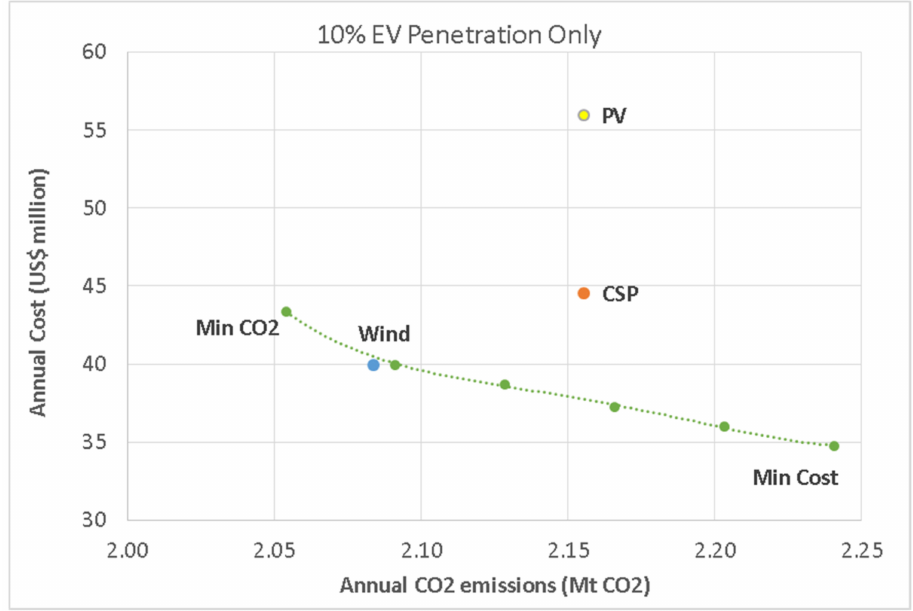
Figure 6. Tradeoff between annual cost and carbon emissions for each case study (different energy generation configurations) for considering 10% EV charging